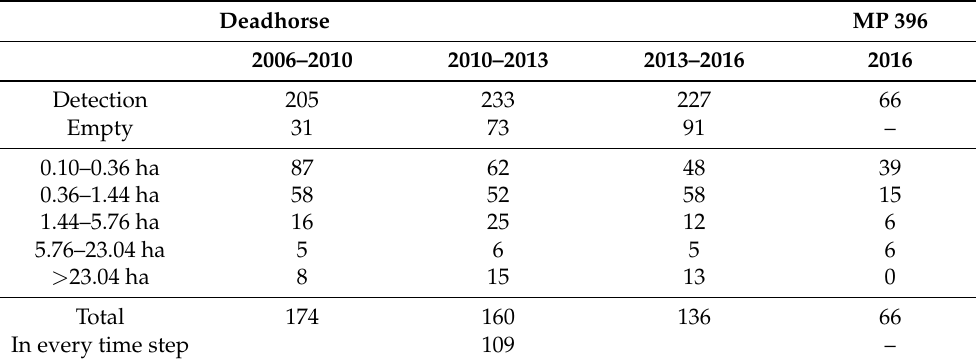
Table 2. Total number of derived water bodies at both study sites, broken down into the five lake size categories. Water bodies were labeled “detected” if they occurred in both years of the analyzed time step at the Deadhorse study site. Water bodies labeled as empty represent the number of lakes that were only detected in the first year. A total of 109 lakes occurred throughout all the time steps.